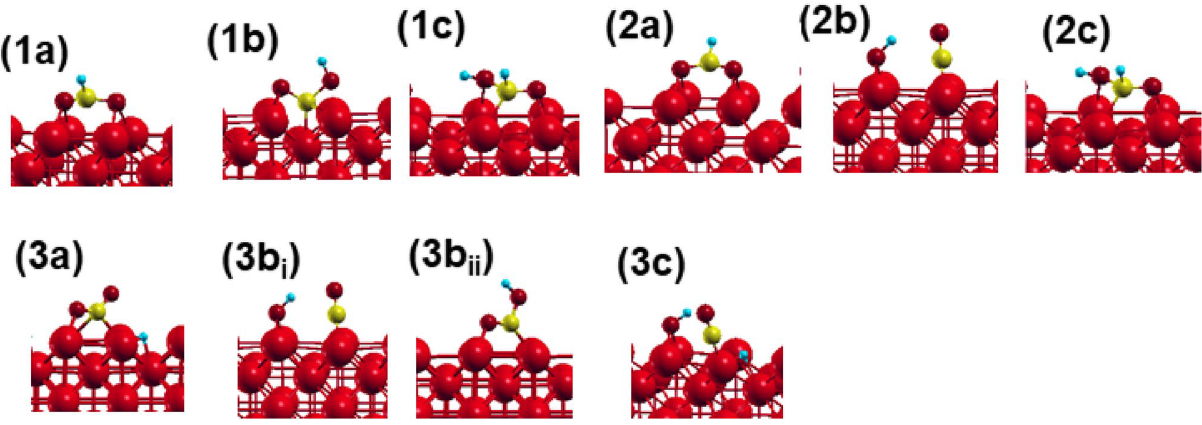
Fig. 4 Optimized structures of hydrogenated carbon dioxide